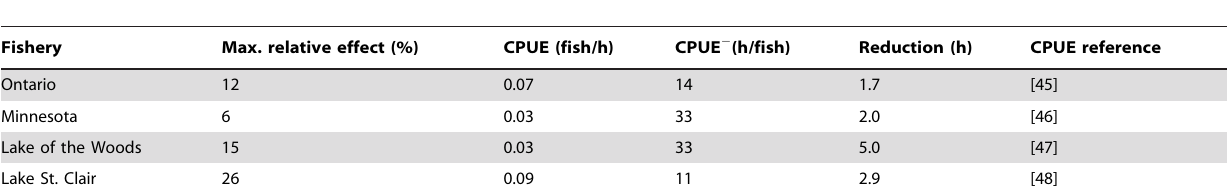
Table 2. Reduction in the time required to catch a muskellunge based on catch per unit effort (CPUE) and the relative lunar effect based on the best two-predictor model (see Table